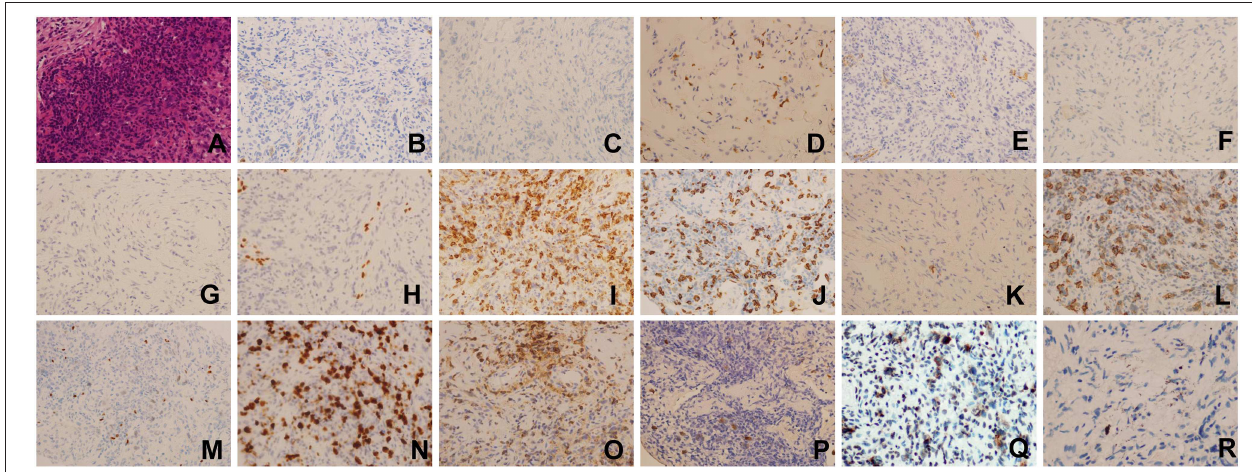
FIGURE 2 | Histopathologic examination and Immunohistochemical staining results of lung biopsy specimen( × 400). (A) Hematoxylin-eosin (HE) staining, (B) AE1/AE3(–), (C) ALK1(–), (D) CD3(–), (E) CK7(–), (F) P40(–), (G) P63(–), (H) TTF(–), (I) CD4(–), (J) CD8(–), (K) CD30(–), (L) CD20( + ), (M) Pax-5( + ), (N) Ki67( + ), (O) LCA( + ), (P) EBER(ISH:EBER-positive cells > 50/HPF), (Q) LMP1( + ), (R) EBNA2(–).